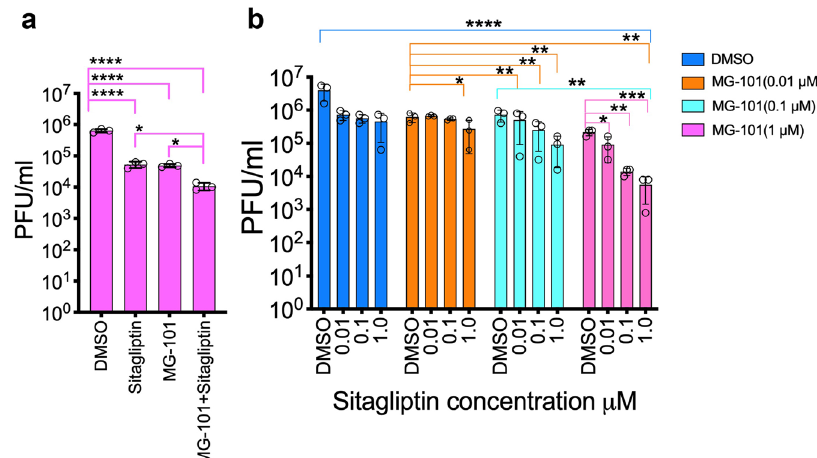
Fig. 6 Antiviral activity of combinations of Mpro and PLpro inhibitors. Effect of combination of Mpro inhibitor MG-101 and PLpro inhibitor Sitagliptin on the growth of SARS-CoV-2 ( a ) and the delta variant ( b ) ( n = 3). Huh7.5 cells were treated with the inhibitors as shown, and reduction in virus titer at 24 h.p.i. was determined by plaque assays. Data are shown as mean ± SEM. p Values were considered signi fi cant when p < 0.05 (*), p < 0.01 (**), p < 0.001(***), and p < 0.0001(****). Table 1 X-ray crystallographic data collection and re fi nement